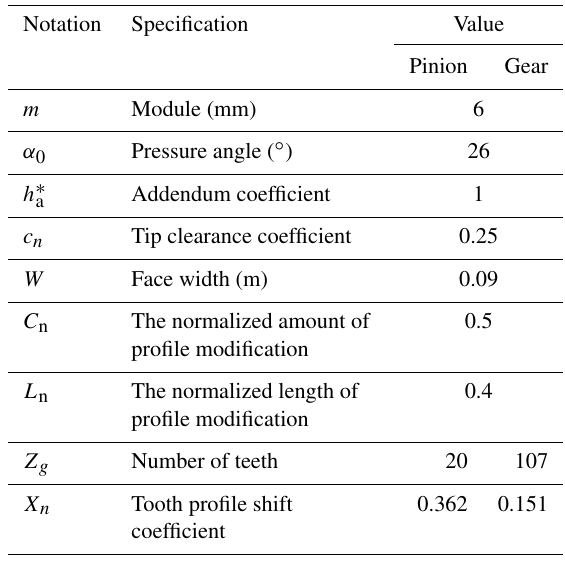
Table 1. Main parameters of the gear pair of the transmission sys-